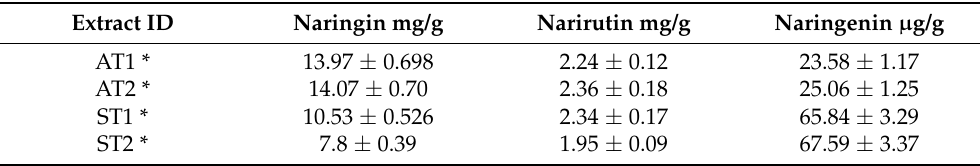
Table 3. Yields of flavanones from control samples using ultrasound extraction method modified with thermal hydrolysis. Results are means ± SD ( n = 3). Extract